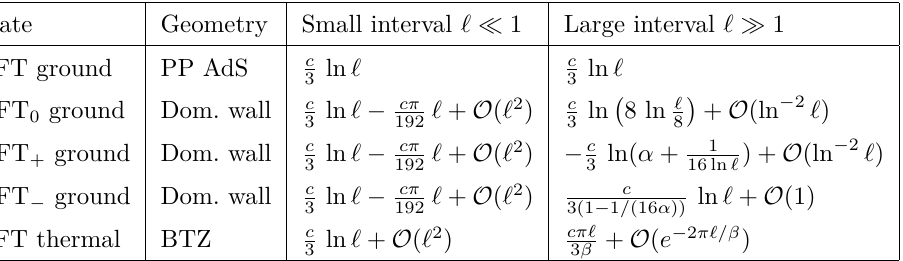
Table 2 . Renormalized EE for various systems at small and large